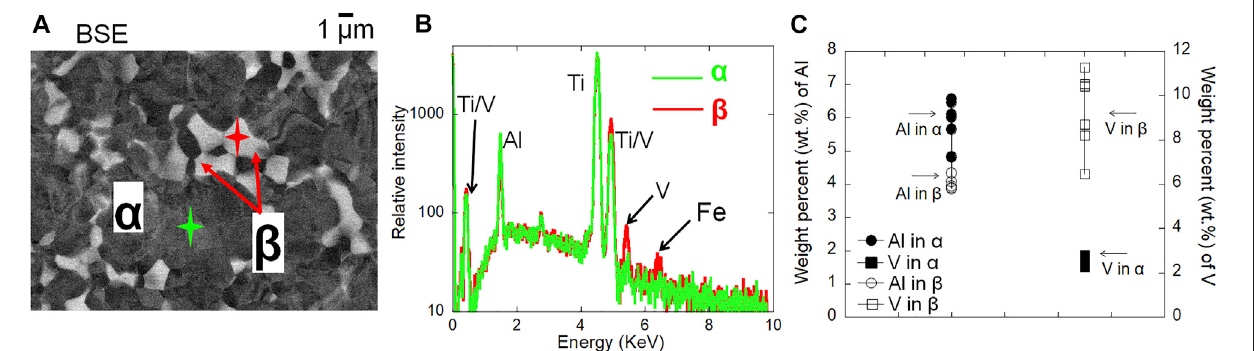
FIGURE 1 | (A) SEM, (B) EDX image and (C) weight percent (wt.%) of Al and V in α phase and β phase of mirror-polished Ti6Al4V based on the EDX analysis of randomly chosen points on the sample.